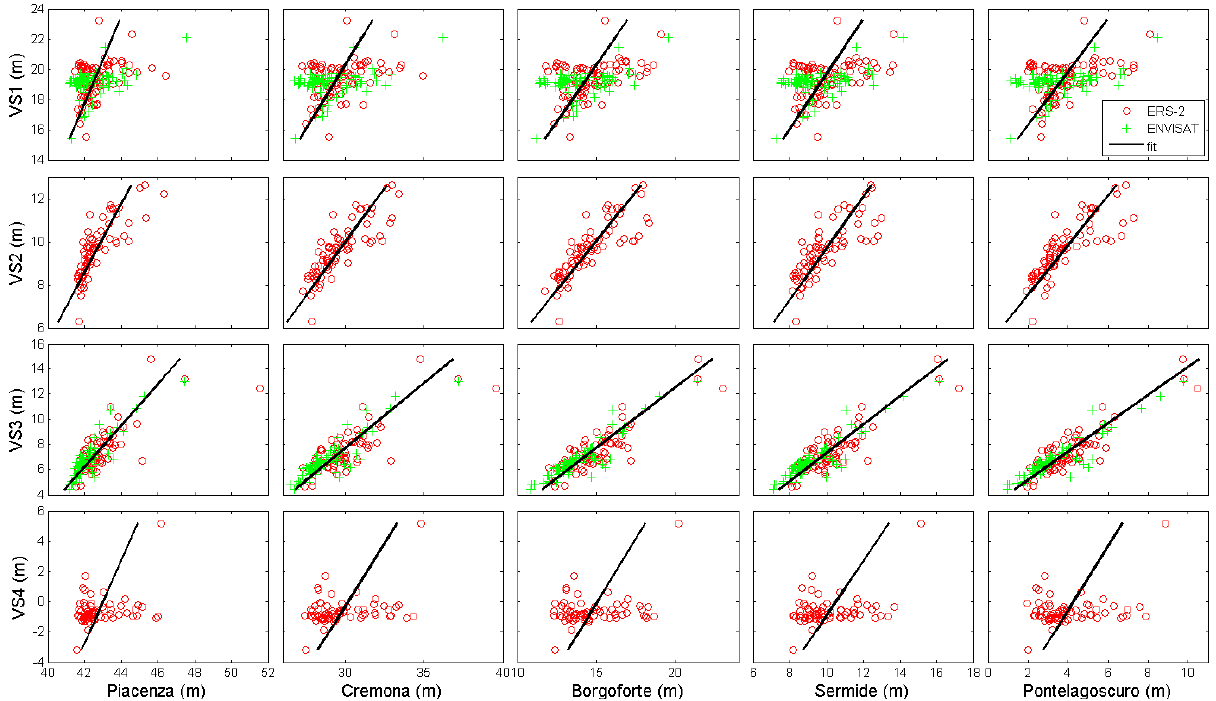
Figure 3. Scatter plot of the water level for in situ and virtual